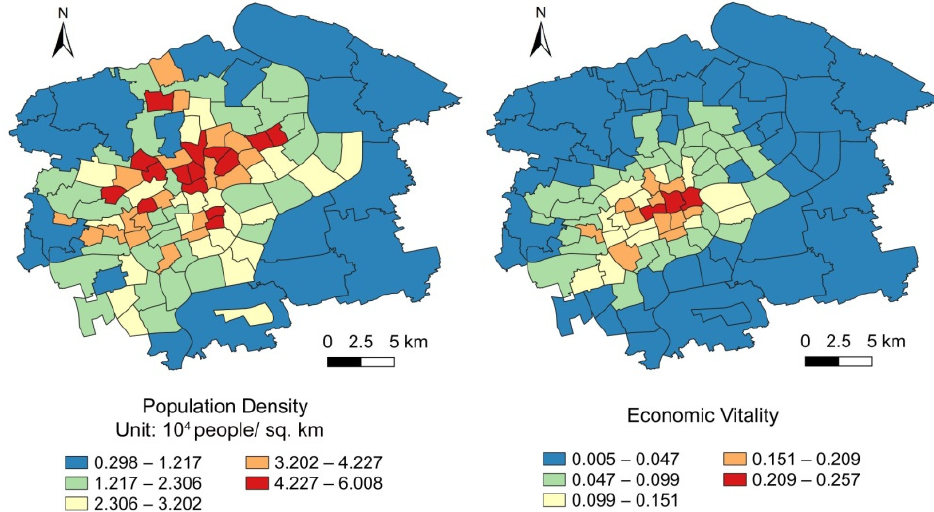
Figure 5. The examples of urban spatial structure indicators and urban vitality indicators. Table 3. Descriptive statistics of the urban spatial structure